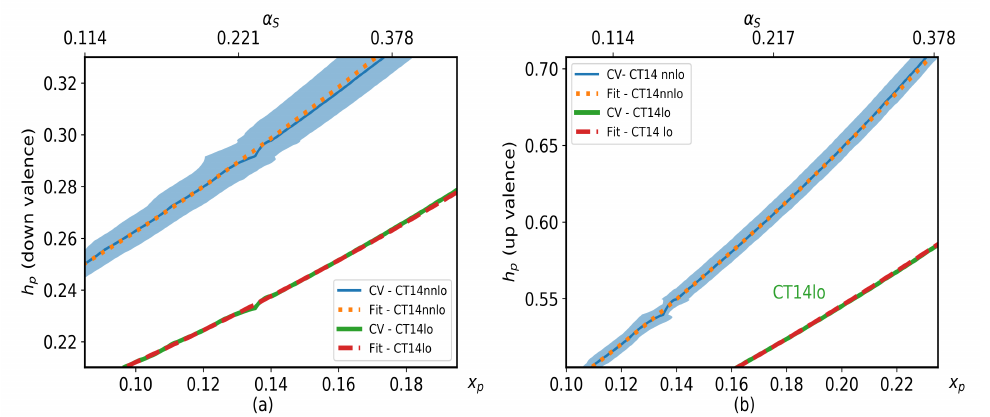
Figure 4. A comparison of the calculations (dotted lines) of Equation (10) with the actual CT14 PDFs [3] for valence d-quark ( a ) and u-quark ( b ) distributions. Parameters C and D are given in Table 1. Solid lines represent the central values (CV) and shaded area is the Hessian error at 68% confidence level of the CT14nnlo parameterization. Only the central value is shown for CT14lo. The top abscissa axis shows the next-to-next-to-leading order (NNLO) strong coupling α S , evaluated at the same Q 2 as the corresponding valence-quark-distribution peak position x p of the bottom abscissa